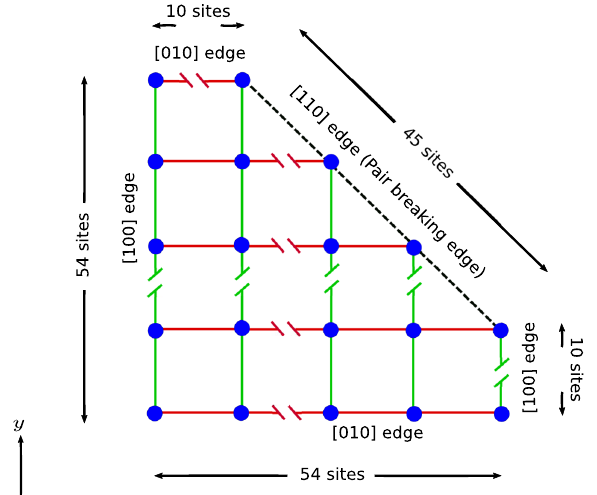
Fig. 7 Schematic of lattice geometry. Sites (blue) arranged in a square lattice with red and green colors indicating opposite signs of the d -wave superconducting pairing amplitude residing on each bond in the bulk. The [110] edge is pair breaking for such superconducting pairing and is shown with a dashed line, while the [010] and [100] edges are non-pair breaking. Kinks indicate that the actual number of lattice sites considered is much larger than what is included in this